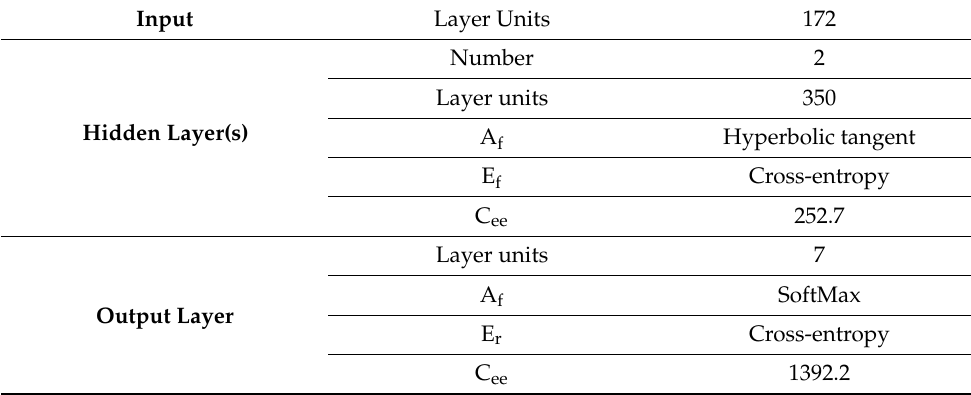
Table 3. The model features of the predictive model.